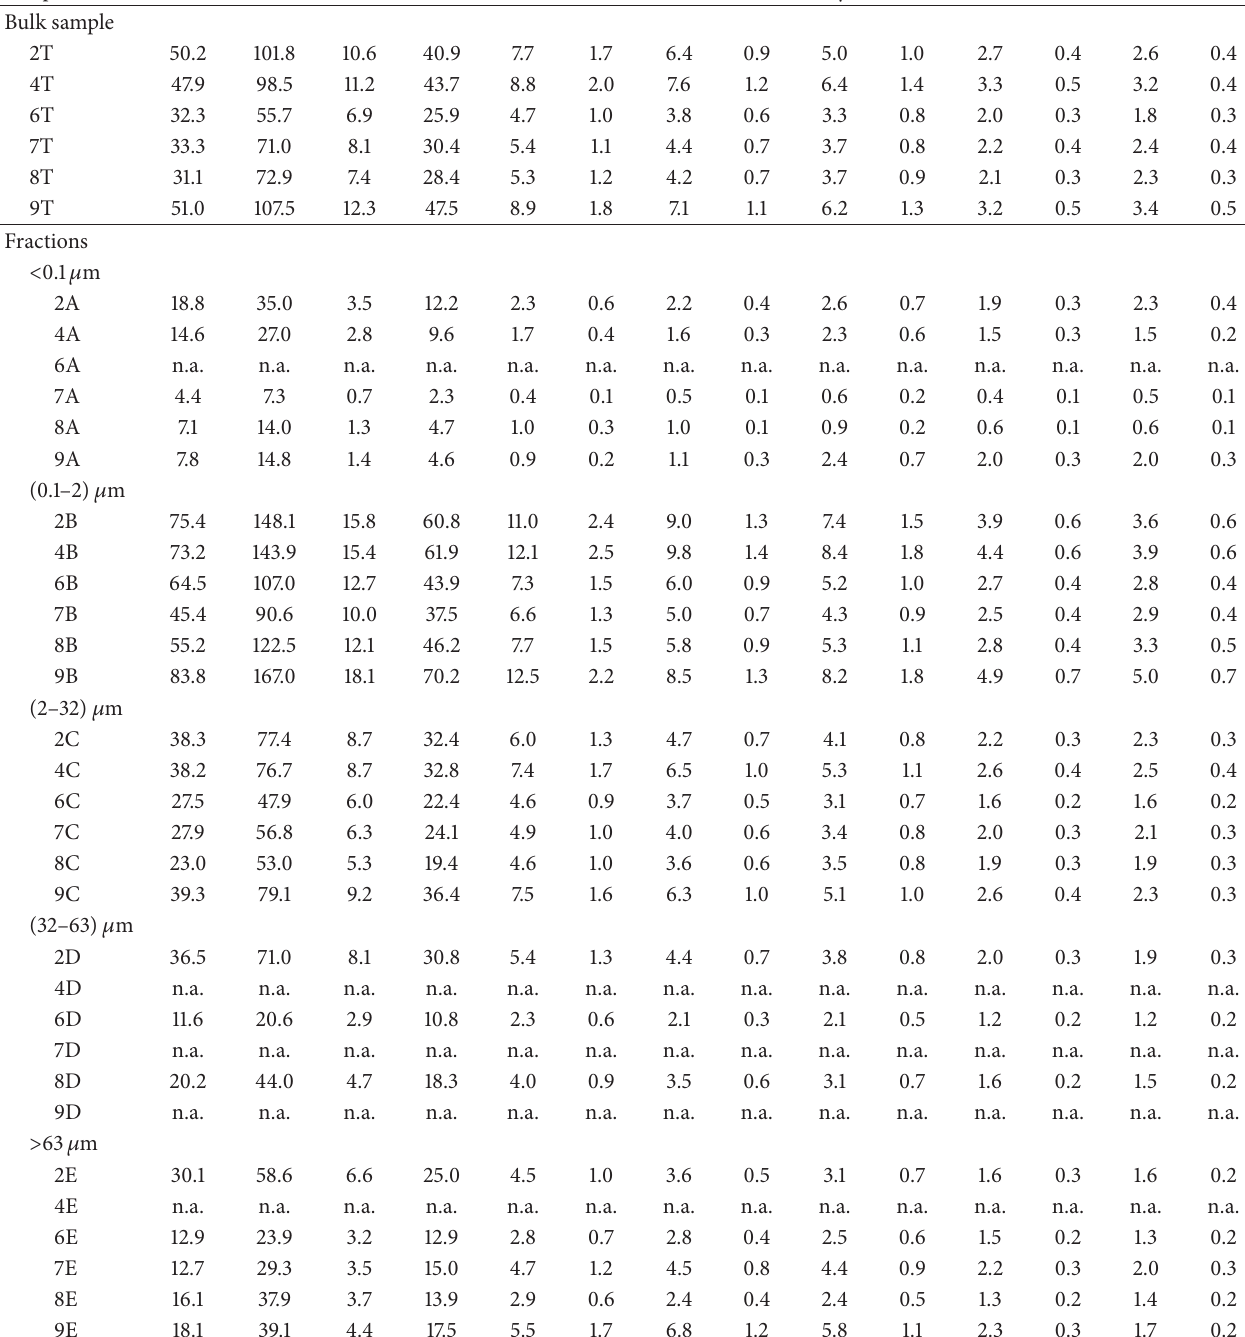
Table 4: The REE abundance (ppm) of the bulk sample and different